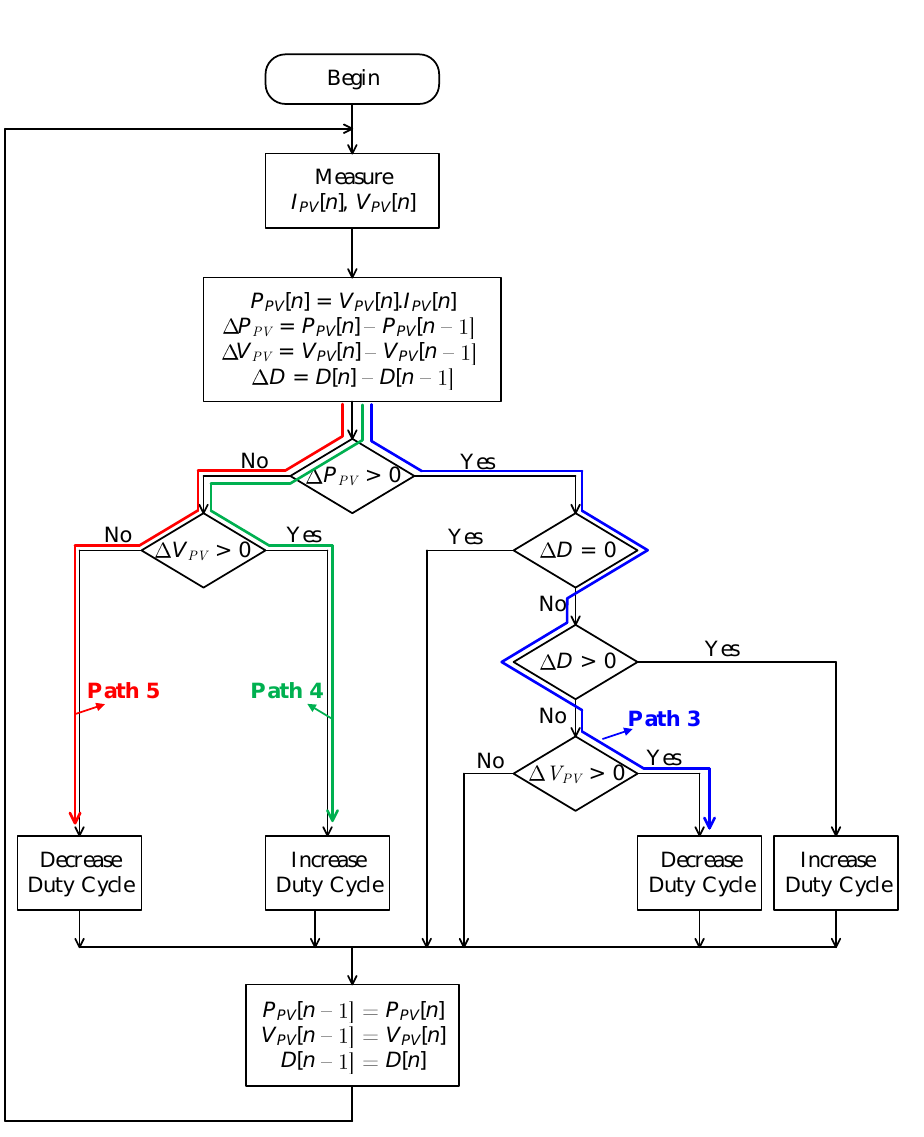
Figure 14. Responses of the proposed algorithm when solar radiation is stable: Path 3, Path 4, or Path 5. The proposed MPPT algorithm utilizes three parameters ( ∆ P PV , ∆ V PV , and ∆ D ), which provide the cases of execution, as shown in Table 1. Table 1. Executions of the proposed MPPT